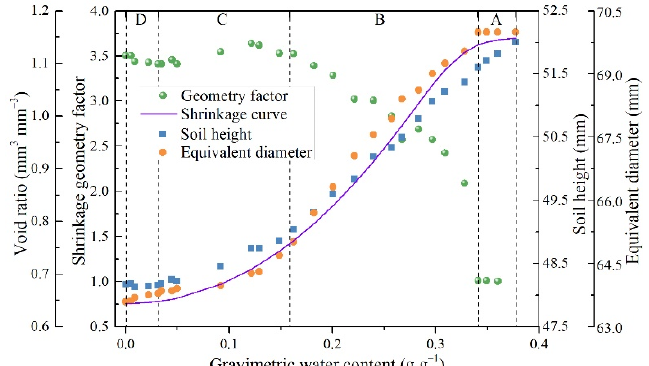
Figure 8. Correspondence among the evolution of soil height, equivalent diameter, soil shrinkage curve and shrinkage geometry factor during drying. A, B, C and D represent structural, proportional, residual and zero shrinkage zones, respectively. For brevity, only the data of replicate 1 during the first drying path are presented.